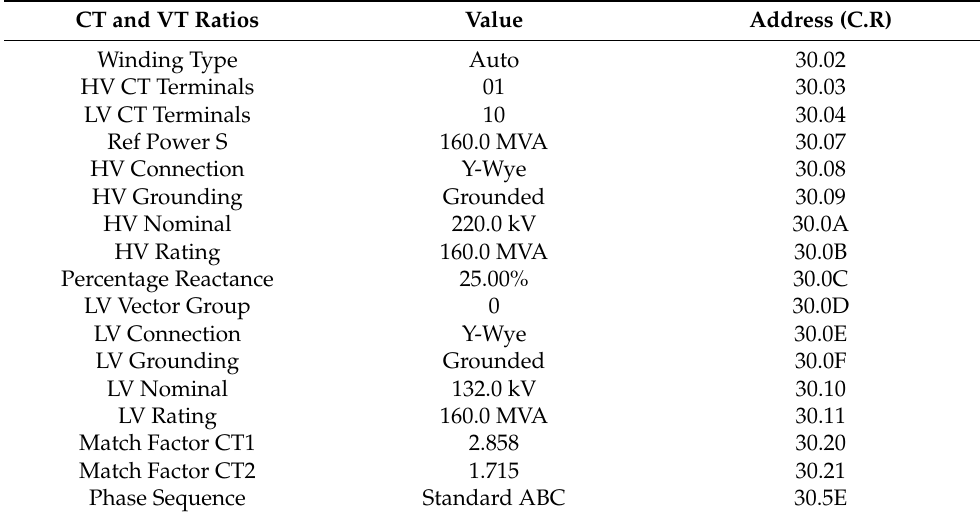
Table 3. Auto transformer implementation in relay.